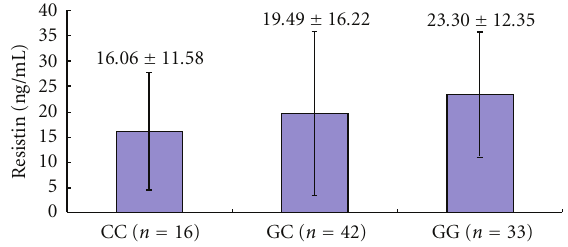
Figure 3: Serum resistin levels in Kawasaki disease (KD) children with CC, GC, and GG